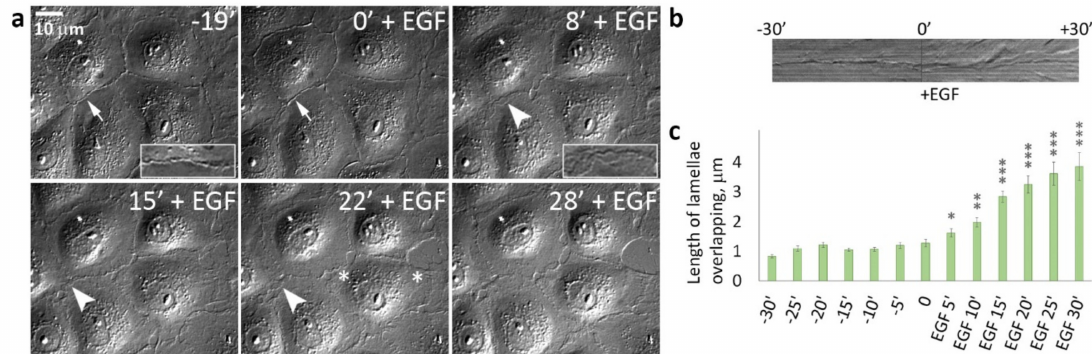
Figure 2. Disappearance of contact paralysis in IAR-20 epithelial cells after the addition of EGF. ( a ) Selected frames from Video S2. The cell-cell boundaries (indicated with arrows and arrowheads) are enlarged in boxed regions. In control cells, the thin “scars” of cell-cell contacts are seen at the cell-cell boundaries (arrows). In the presence of EGF, cell-cell interfaces became highly unstable (arrowheads) and overlapping lamellae were seen at the cell-cell boundaries. Asterisks indicate sites of disruption of cell-cell contacts. ( b ) Kymograph generated at the site of the cell-cell contact shows contact paralysis before EGF addition and appearance of protrusive activity caused by addition of EGF. ( c ) Length of lamellae overlapping at the cell-cell boundaries. * p < 0.05, ** p < 0.001, *** p <